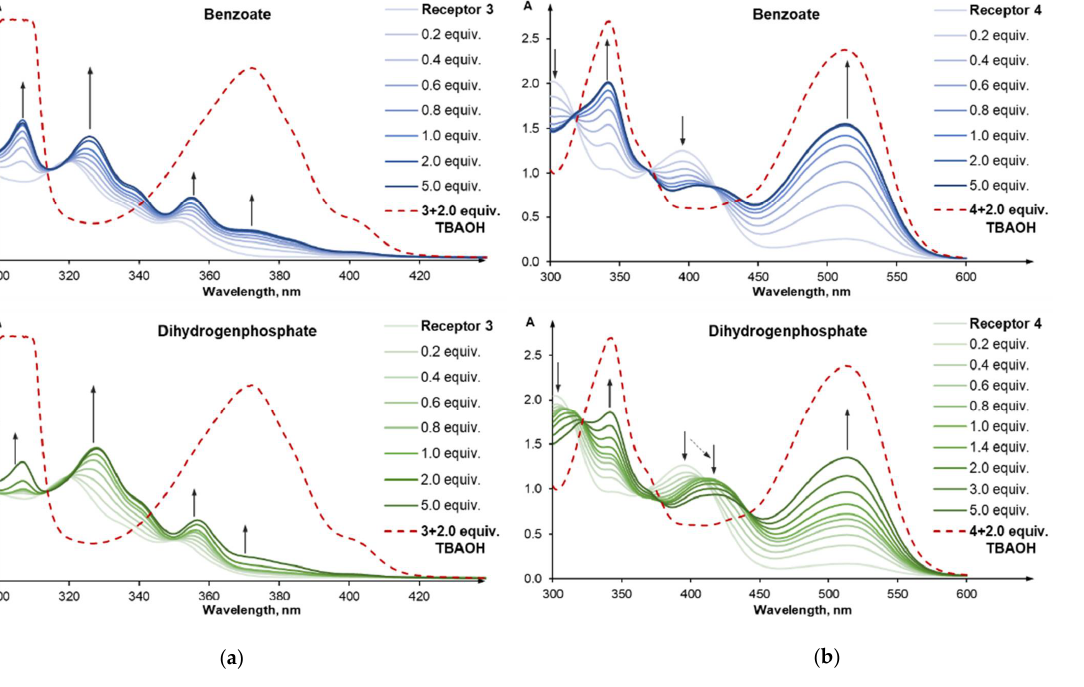
Figure 4. UV-vis titration of: ( a ) 3 (10 −4 M) with TBAPhCOO (top) and TBAH 2 PO 4 (bottom); ( b ) 4 (10 −4 M) with TBAPhCOO (top) and TBAH 2 PO 4 (bottom) in DMSO + 0.5% H 2 O at 298 K.